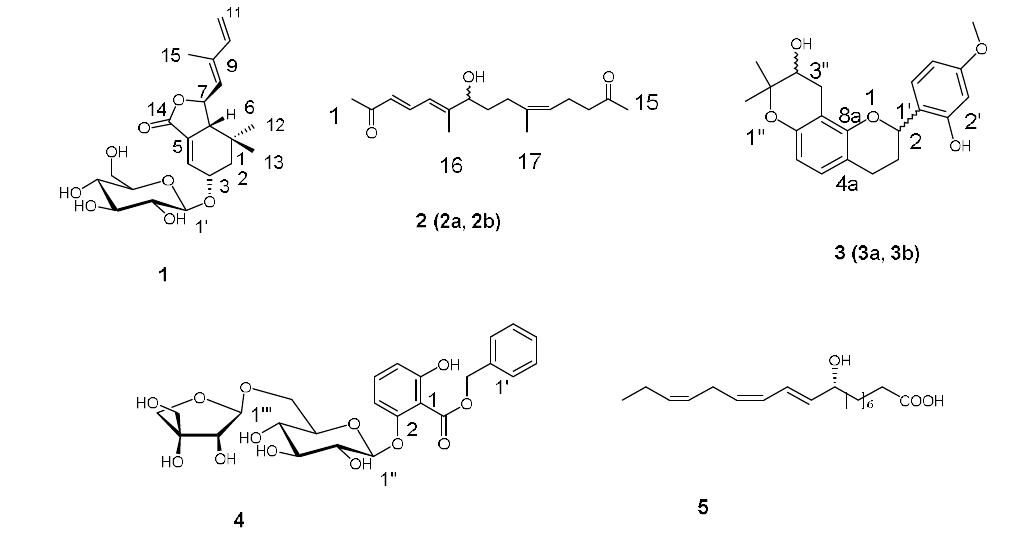
Figure 1. Structures of Compounds 1 – 5 . Table 2. 13 C-NMR Spectroscopic Data of Compounds 1 − 4 a .